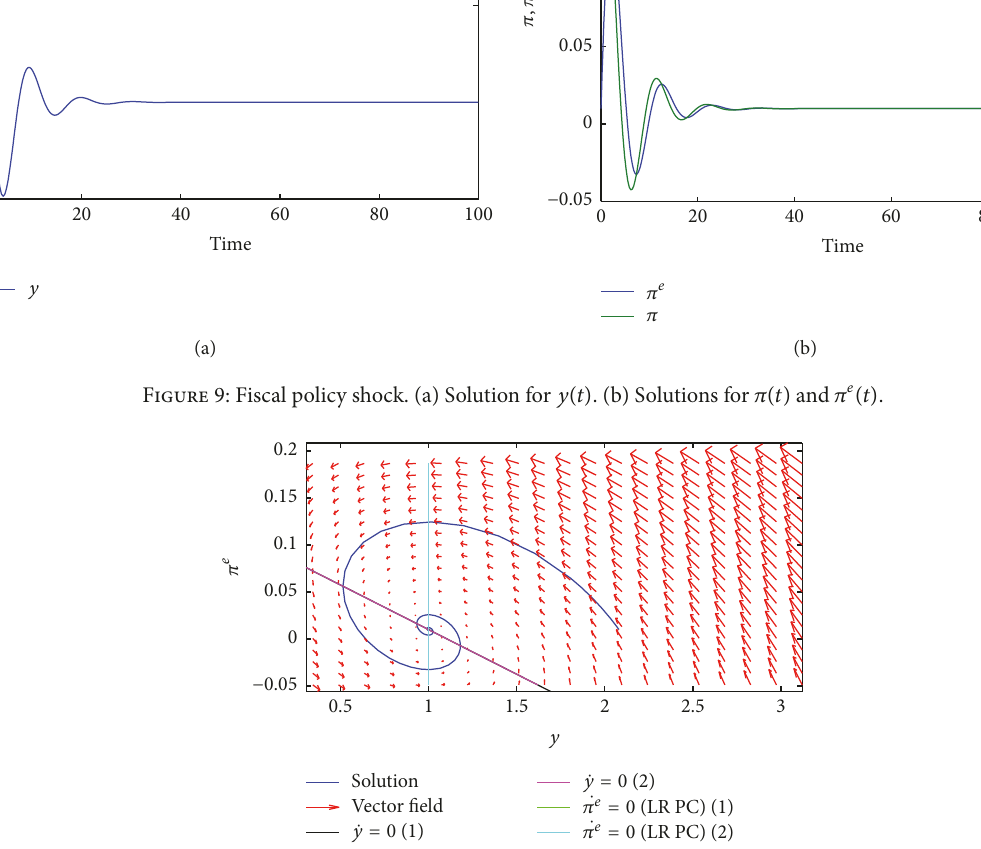
Figure 10: Phase diagram portraying the dynamic adjustment after a fiscal policy